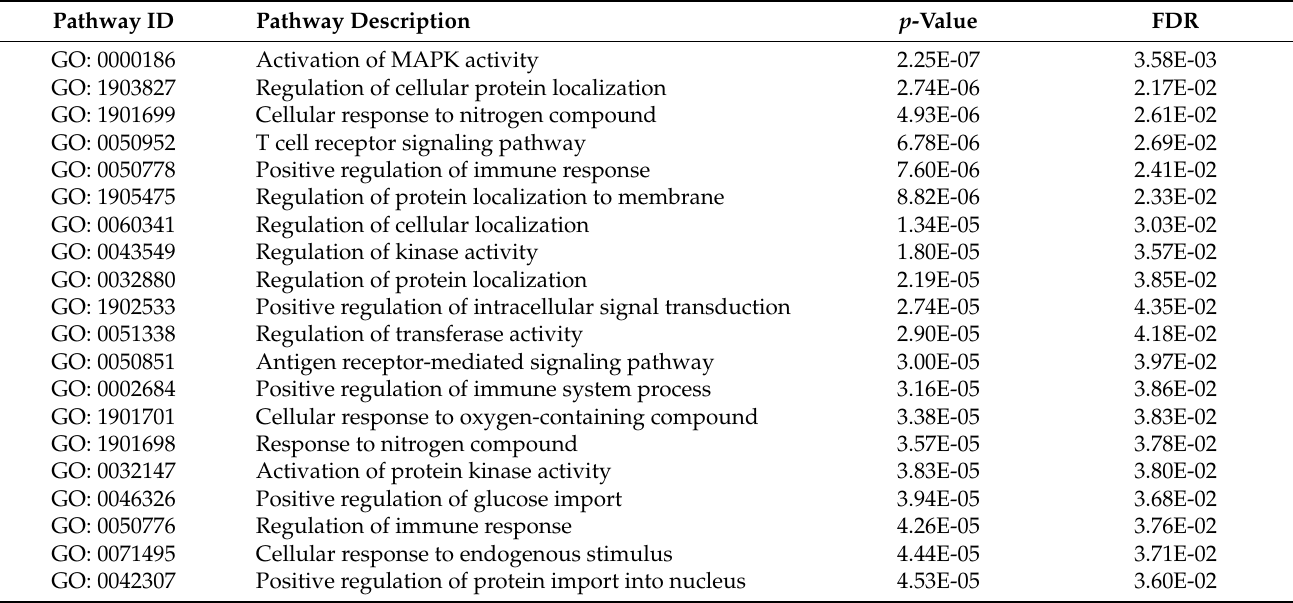
Table 2. Enriched terms generated by Gene Ontology for the main target genes of downregulated miRNAs.